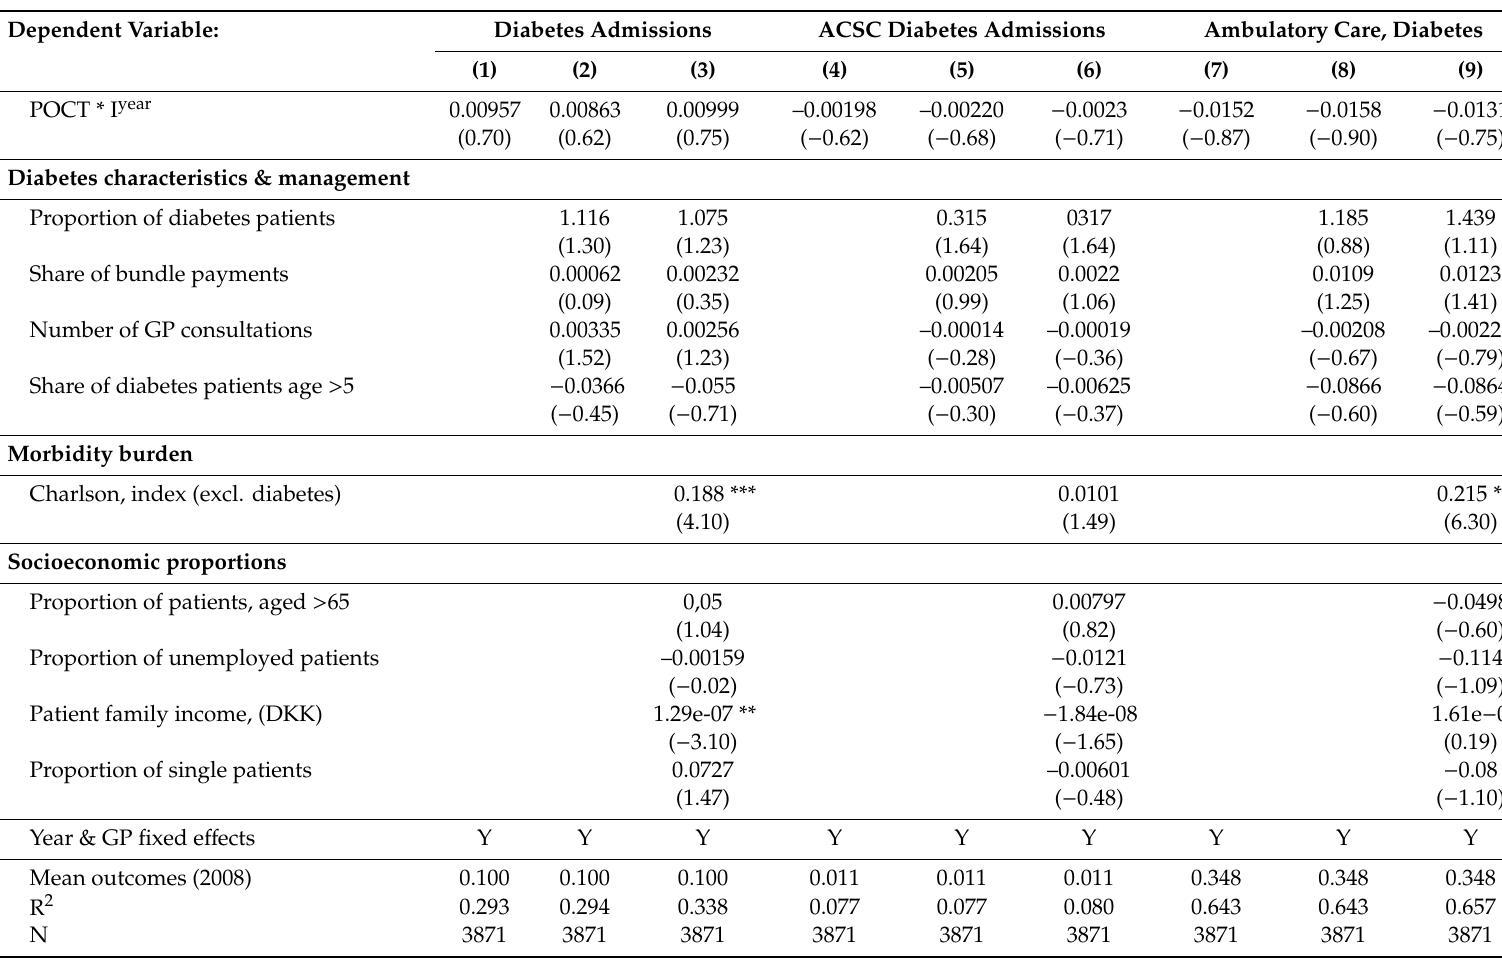
Table 6. Average e ff ect of POCT of HbA1c for standard di ff erence-in-di ff erences (DID) model with continuous treatment